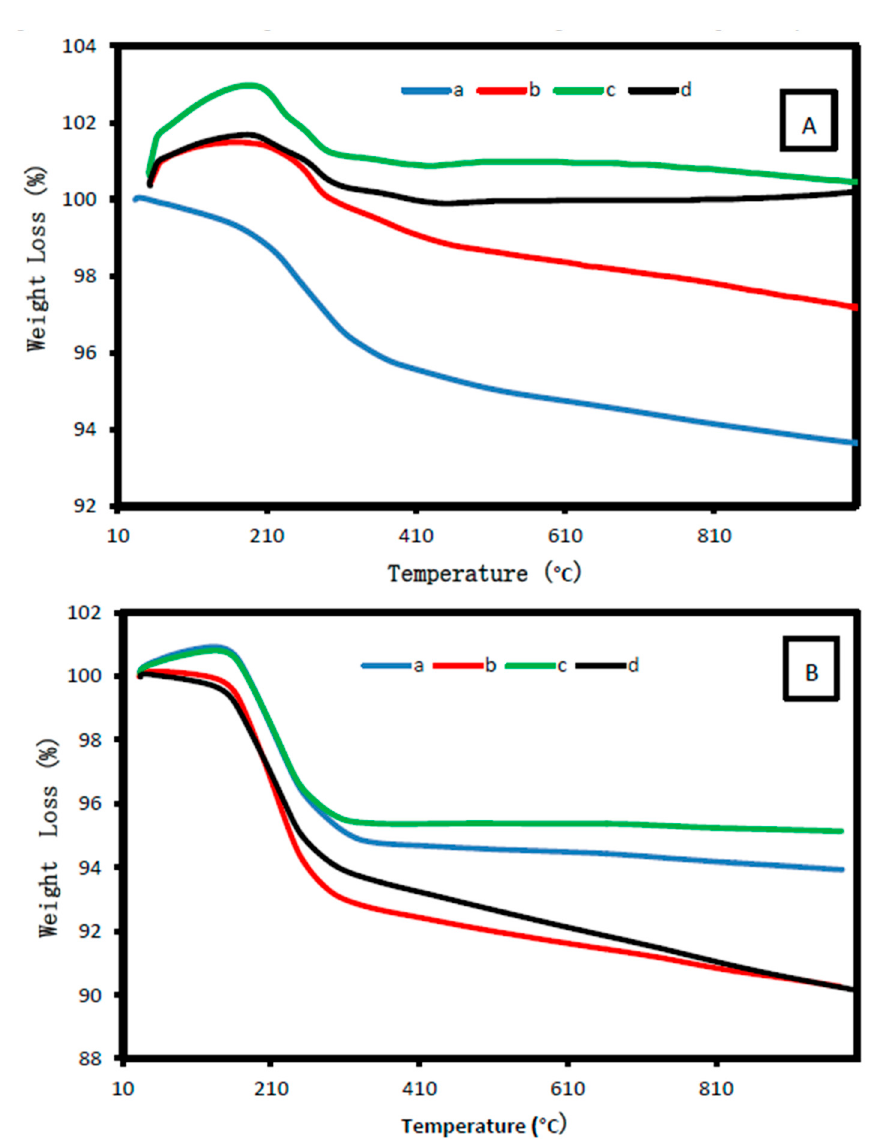
Figure 7. TGA of ( A ) Ni/Mg 1 − x Ce 4+x O and ( B ) Ni,Pd,Pt/Mg 1 − x Ce 4+x O catalysts, where (x = a (0.00), b (0.03), c (0.07), and d